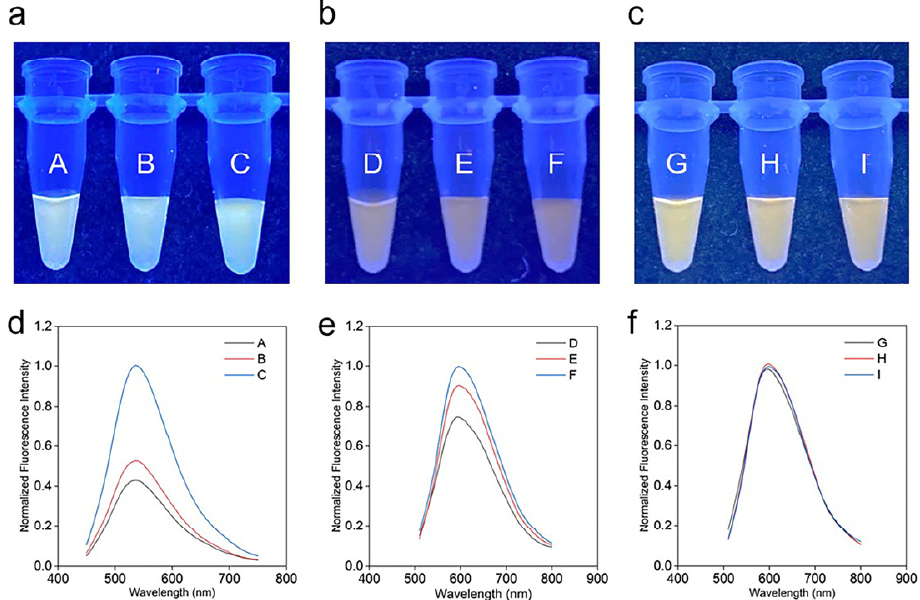
Figure 4. Colorimetric responses (digital images) of varying amounts (1 × , 10 × , 0 × ) of ( a ) exosomes with PT in MilliQ in Vials A–C, ( b ) exosomes with PT in PBS in Vials D–F, and ( c ) exosomes with PT-T20 in PBS in Vials G–I, and their corresponding fluorescence spectra ( d – f ), respectively.